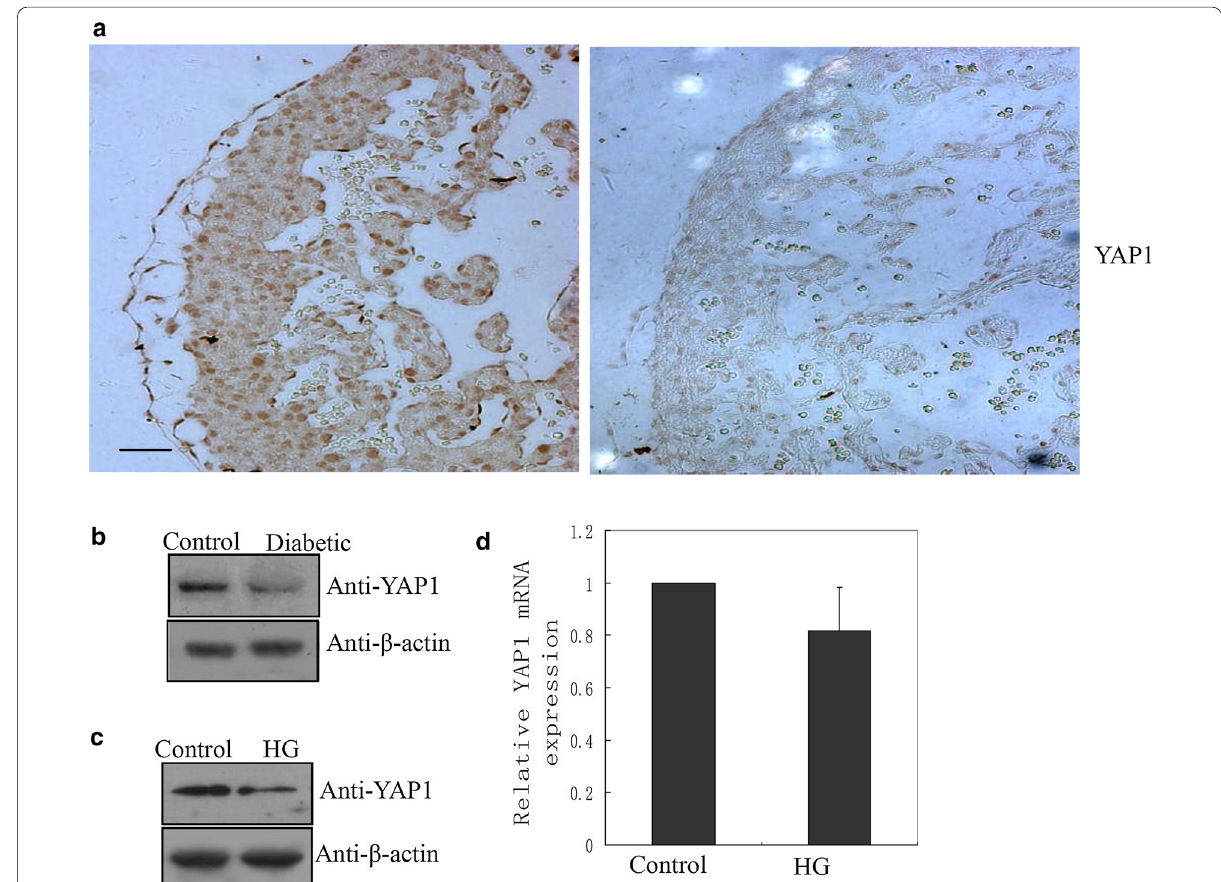
Fig. 3 Association between knockdown of yes-associated protein 1 (YAP1) and mammalian sterile 20-like kinase 1 (MST1)-mediated cardiomyocyte apoptosis. a Immunohistochemical staining showed of YAP1 in the myocardium of normal and diabetes-exposed embryos (n b Western blotting with the indicated antibodies confirming the decrease in YAP1 protein in fetal hearts at E15.5 from the normal and diabetic groups (n 8 each). β-actin was used as an internal reference control. c Western blotting of YAP1 protein in cardiomyocytes after 2 days of high = glucose (HG) treatment; experiments were replicated 3 times. d The mRNA expression of YAP1 in cardiomyocytes after HG treatment; data are based on three independent